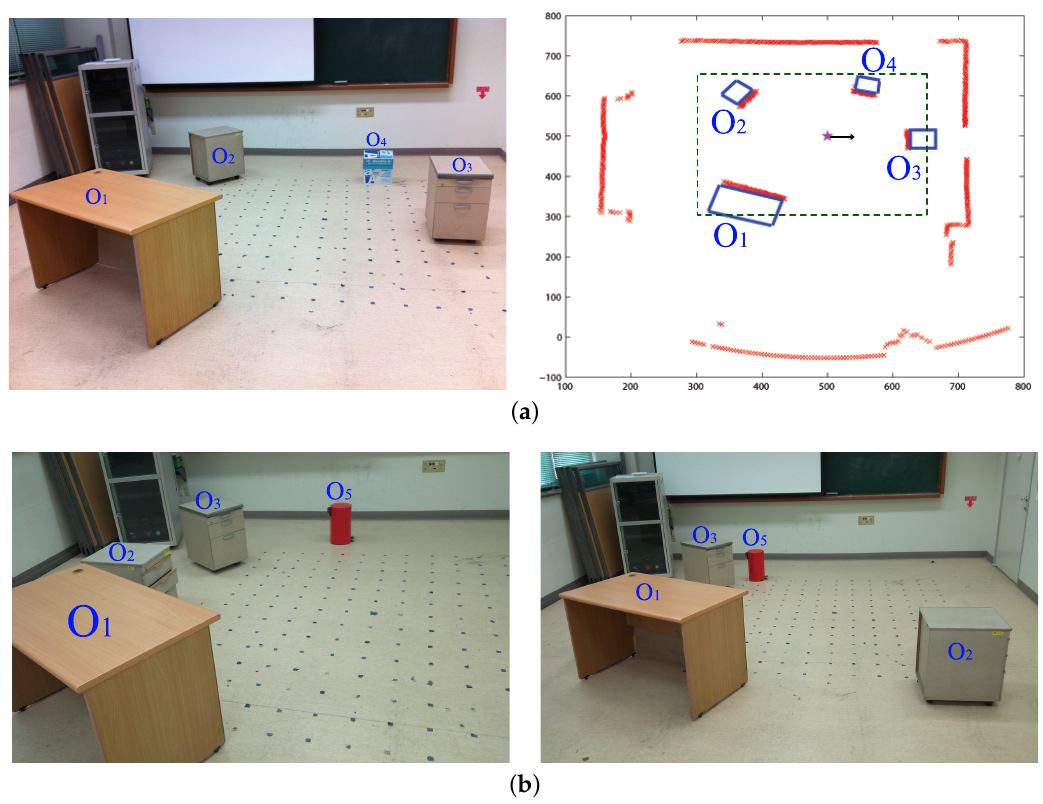
Figure 2. Test environments ( a ) environment env1 ( left : environment, right : distance map at the home location with a laser sensor, *: home location); blue lines: top-view of objects, green dashed rectangle: interest zone for test points, called Region 2, black arrow: the reference direction (zero degree). The laser sensor collects the range data in a counterclockwise direction, and red x marks indicate detection points read by the laser sensor; ( b ) environments, env2 ( left ) and env3 ( right ) ( O 1 ,..., O 5 : objects).